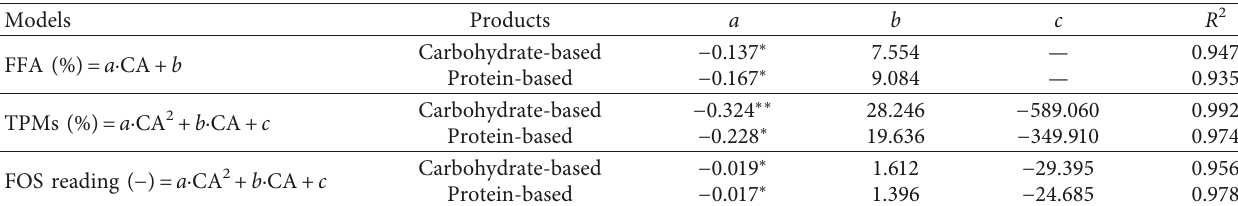
Table 3: Regression results of contact angle (CA) models for prediction of chemical qualities of frying oil. Models